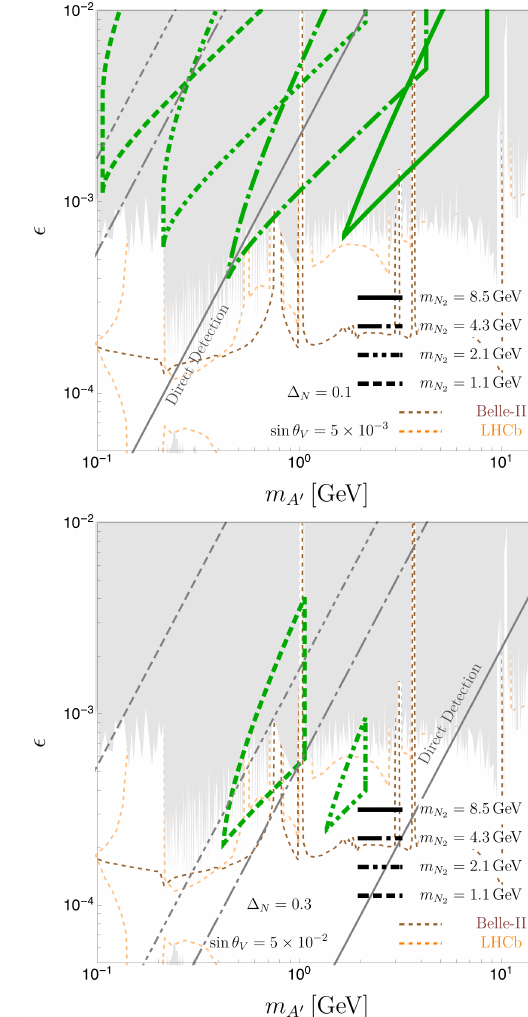
Figure 11 . Dark nucleon searches at the LHC lifetime frontier on (cid:15) - m A 0 plane: FASER (left columns) and MATHUSLA (right columns). We choose different values from the parameters taken in figure 4: we take the mass difference to be ∆ = 0 . 1 (top) and 0.3 (bottom), and the mixing N angle to be sin θ = 5 × 10 − 3 and sin θ = 5 × 10 − 2 . The color codes and the existing V V